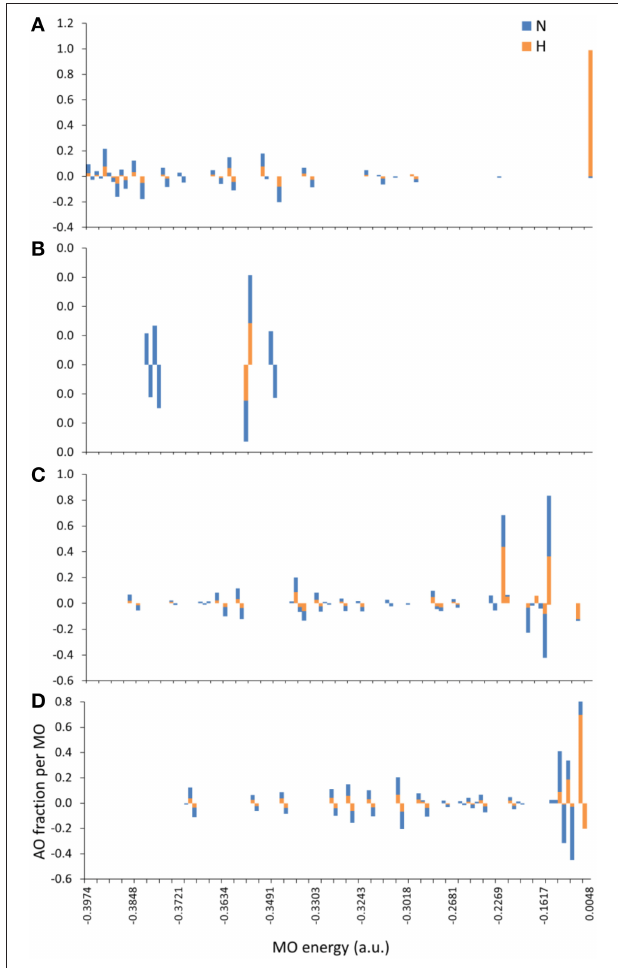
FIGURE 11 | MO contributions (fractions) by N terminus atomic orbital (AO) populations. From (A–D) : Tax (charge (z) -2, spin polarization (s) 2), V7R (z-1, s1), Y8A (z-1, s2), and P6A (z-2, s2) respectively. All triggering side chains were deprotonated. Each bar corresponds to the sum of a 1g and t 1u contributions either by the N atom or by the group of the three H atoms on the N terminus. Majority (spin up) and minority (spin down) populations are shown as positive and negative AO fractions,